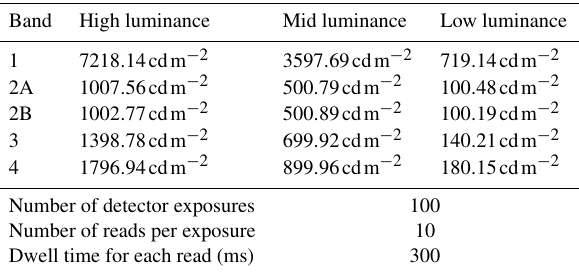
Figure 14. Instrument line shapes for Band 2A estimated from ar- gon emission lamp measurements. The numbers in the legend give the location in pixel space for each emission line (see second panel of Fig. 12). Table 4. Measurements of the NERC FSF integrating sphere used for the radiometric calibration of GHOST. The external 150W lamp was used with a variable aperture to produce the output luminances listed.